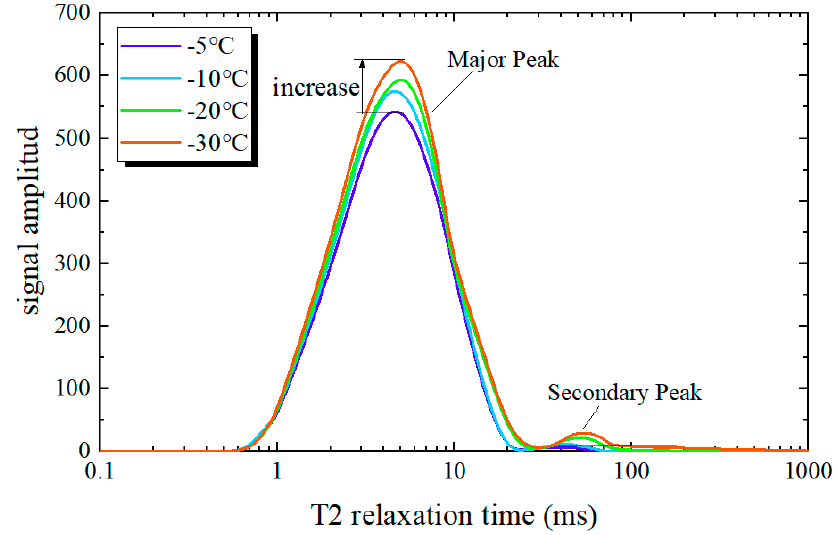
Figure 4. The T 2 spectrum curves of thawed soils under different freezing temperatures.